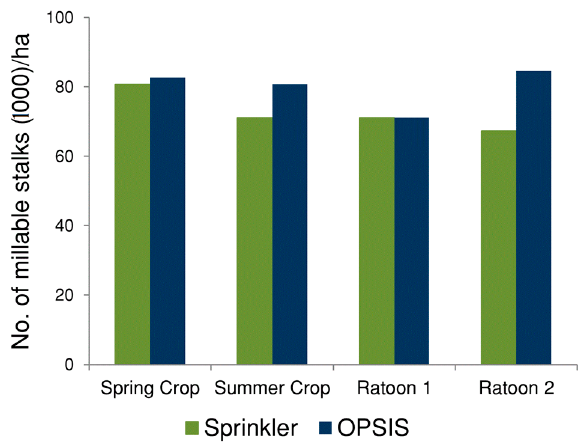
Figure 7. Number of millable stalks of sugarcane cultivar Ni21 as affected by irrigation method.